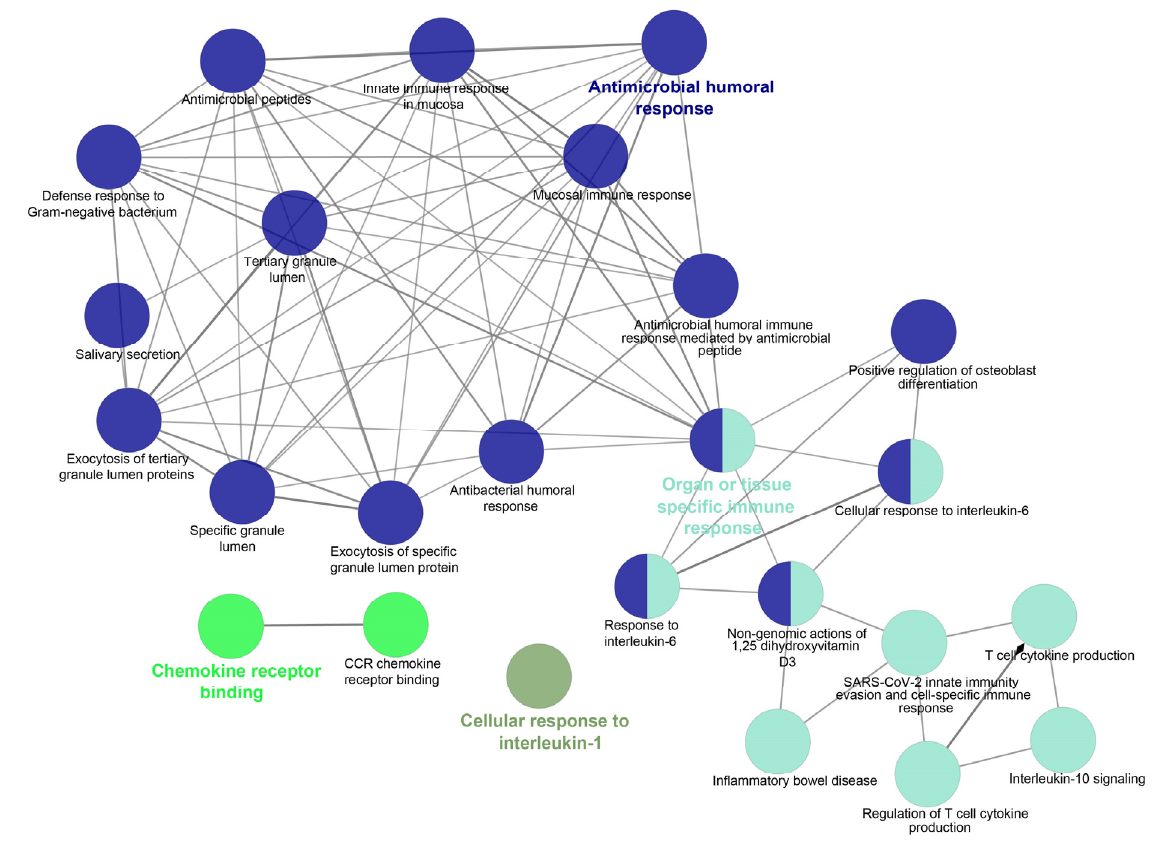
Figure 5. PPI Pathway analysis using Cytoscape plugin ClueGO to interpret the functional pathways and functions of each gene responsible for antimicrobial activity in lung airways. Different-colored circles indicate different functions or functional pathways as mentioned in the figure. Table 2. AMP genes, which are used in gene expression profiling.